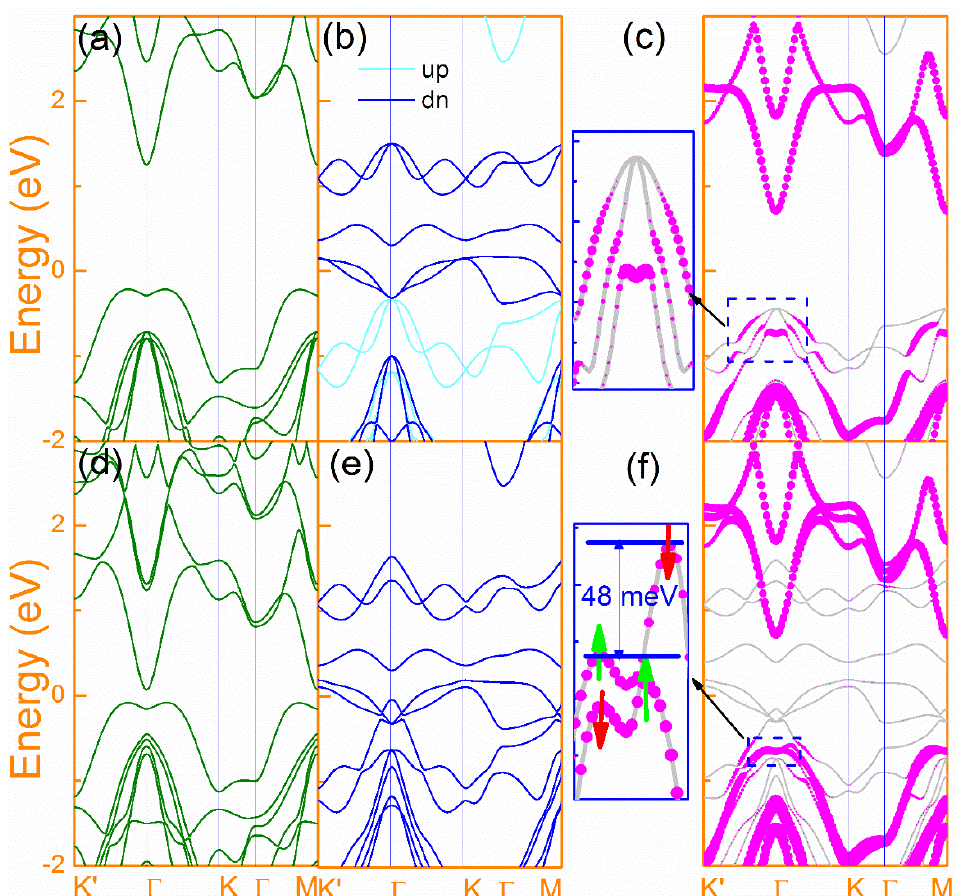
Figure 2. The band structures of InSe ( a , d ), FeI 2 ( b , e ) and InSe / FeI 2 in C-1 configuration ( c , f ). The top and bottom panels are the ones without and with SOC. In ( b ), the cyan and blue lines are the spin-up and spin-down components. In ( c , f ), the pink solid dots indicate the contributions from InSe with their size reflecting the relative weight. The insets at left part of ( c , f ) are the zoom-in views of the valence top of InSe, where the spin and valley splitting in ( f ) are noticed.